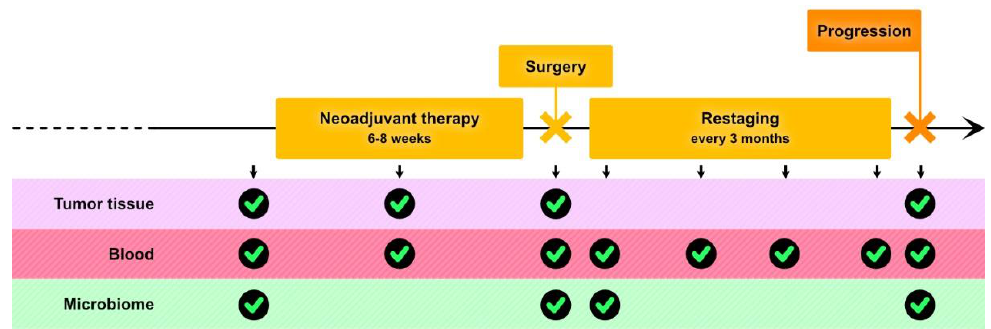
Figure 1. General outline and biospecimen collection for a neoadjuvant trial for melanoma. Adapted from the International Melanoma Neoadjuvant Consortium [65].